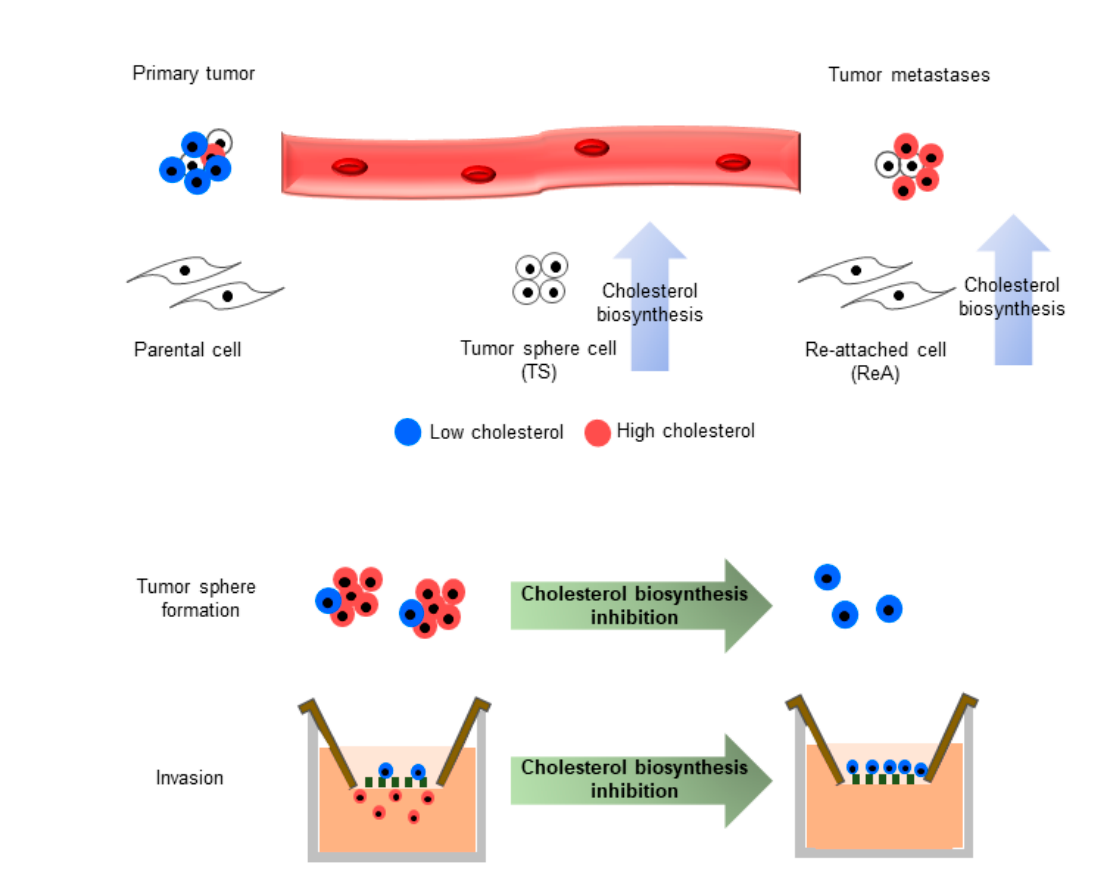
Figure 6. A schematic model showing the relationship between cholesterol synthesis and distant metastasis. ( A ) During distant metastasis of breast cancer, the primary tumor metastasizes via CTCs. Cholesterol synthesis is commonly increased in CTC-mimicking TS and tumor metastases-mimicking ReA cells. ( B ) Inhibition of cholesterol synthesis reduces tumor sphere formation and invasion ability.